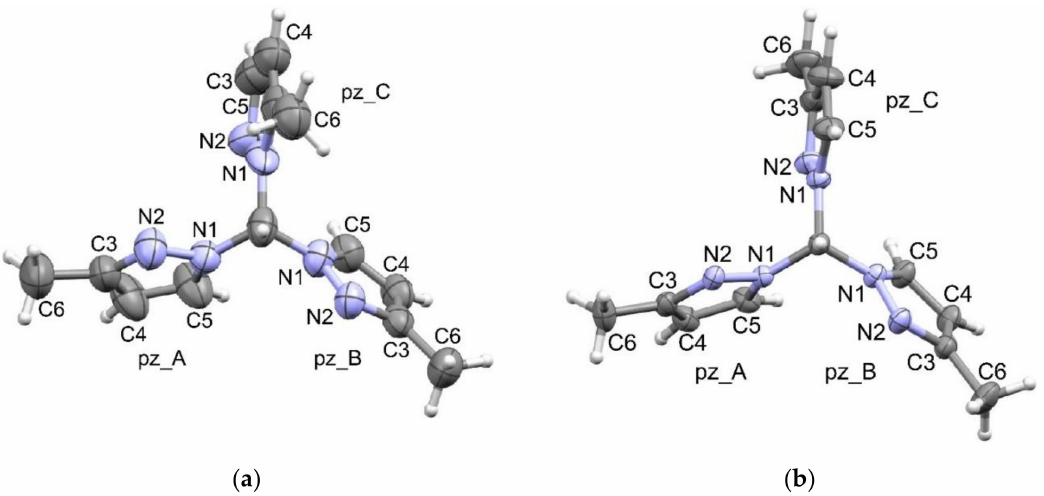
Figure 3. A view of the structure of ( a ) the 333 isomer (Cambridge Structural Database (CSD) [21] refcode: TUYZEU) and ( b ) the 335 isomer (bis(3-methylpyrazolyl, 5-methylpyrazolyl)methane). Displacement ellipsoids are drawn at 50% probability level. Hydrogen atoms are represented as spheres of 0.1Å